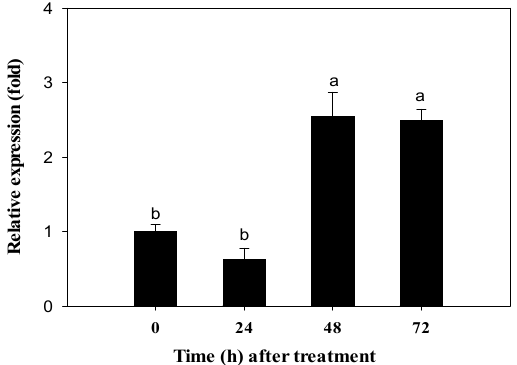
Figure 4. Relative gene expressions of CYP340W1 in ABM-R after the third instars were treated with LC 10 concentration of abamectin for different time. Expression at 0 h was set to 1. Data are presented as means ± SE. The lowercase letters above the error bars mean significant difference in expression levels according to Tukey’s test p < 0.05 ( n = 3).